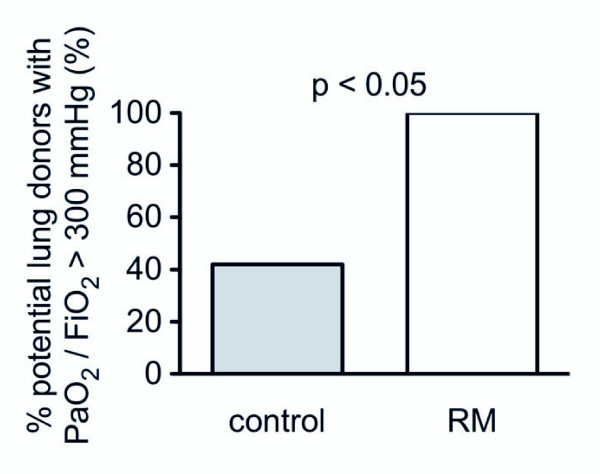
Variation of percentage of potential lung donors according to PaO2/FiO2 criterion (between T1 and T3 from 100% at T1. PaO2/FiO2, arterial oxygen tension/fractional inspired oxygen. RM, recruitment maneuver.